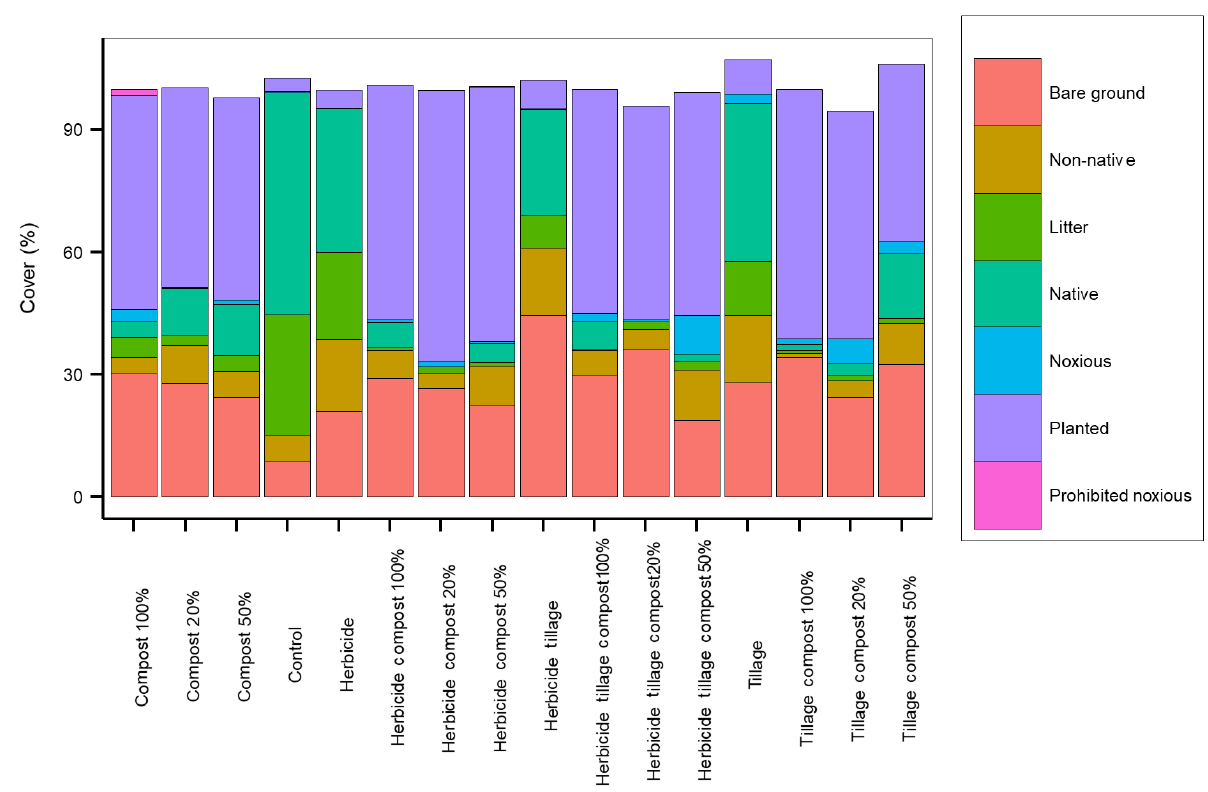
Figure 3. Percent cover by category for site preparation and soil amendment treatments.